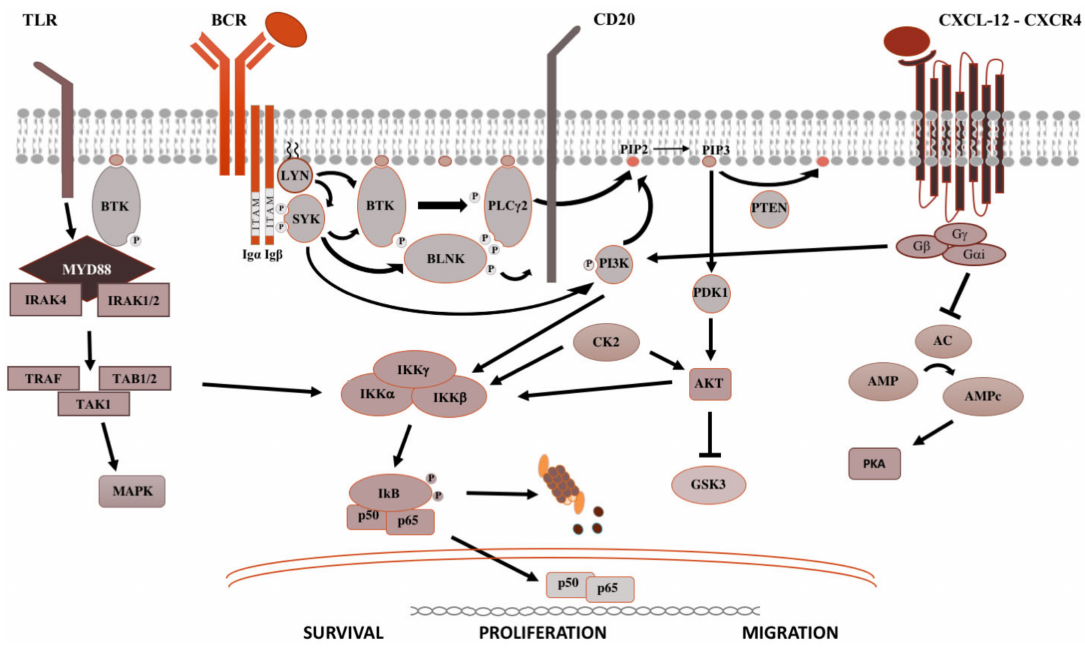
Figure 1. Pivotal signaling pathways in lymphoproliferative diseases. On the left side, TLR signaling is shown. Upon recognition of PAMP (pathogen-associated molecular patterns) by TLR (toll-like receptors), MYD88 is recruited to the cell membrane, binds the serine-threonine kinase IRAK proteins (IL-1R associated kinase), TRAF (tumor necrosis factor receptor-associated factor) and TAK1 (transforming growth factor beta-activated kinase 1) [8], which activate the MAPK (mitogen-activated protein kinase) cascade and IKK (inhibitor of the NF- κ B kinase). IKK complex is made up of IKK α and IKK β , with kinasic activity, and the regulatory IKK γ subunit. Once activated, IKK phosphorylates I κ B (inhibitor of NF- κ B), leading to its ubiquitylation and proteasomal degradation, thereby, the release of the NF- κ B (RELA p65–p50 in the classical pathway and RELB-p52 in the alternative pathway). Then, NF- κ B subunits translocate into the nucleus and modulate the proliferation and survival of B lymphocytes [2]. In the middle is shown the BCR signaling. After antigen binding to the B-cell receptor (BCR), the Src kinase LYN is activated, phosphorylating CD79A/B and recruiting SYK (spleen tyrosine kinase) [9]. LYN and SYK activate by phosphorylation BTK [10], and, subsequently, the phospholipase PLC γ 2, activating NF-kB pathway, MAPK and PI3K pathways. On the right is shown the CXCR4 signaling. After binding of CXCL12 to the seven domains trans-membrane CXCR4 receptor coupled with trimeric G protein, the G α subunit dissociates from the G β /G γ dimer and inhibits adenyl cyclase (AC), causing the reduction of intracellular cAMP (cyclic AMP) levels and switching off PKA (protein kinase A). Meanwhile, the G β /G γ dimer actives PI3K, modulating lymphocytes migration, and phospholipase PLC, which acts on PIP2 (phosphatidylinositol 4,5-bisphosphate) releasing IP3 (inositol 1,4,5-trisphosphate), favoring the mobilization of Ca2+ from intracellular stores, and diacylglycerol, promoting the activation of PKC (protein kinase C) and MAPK cascade